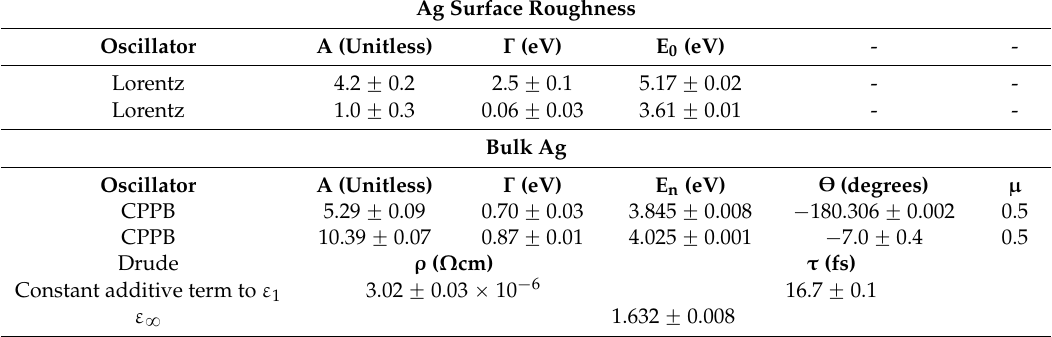
Figure 1. Complex dielectric function spectra, ε = ε 1 + i ε 2 , (arrow pointing left for ε 1 axis, arrow pointing right for ε 2 axis) from 0.734 to 5.88 eV for a semi ‐ infinite Ag film parameterized with a combination of a Drude oscillator and two oscillators assuming critical point parabolic bands (CPPB) with parameters listed in Table 2. Table 2. Parameters describing complex dielectric function ( ε = ε 1 + i ε 2 ) and structure for a semi ‐ infinite Ag film on a borosilicate glass over coated by Cr before ZnO deposition. Experimental ellipsometric spectra were collected in situ after deposition at room temperature in the spectral range from 0.734 to 5.88 eV and fit using least square regression analysis with an unweighted estimator error function, = 5 × 10 − 3 . For bulk Ag, the parameterization of ε consisted of a Drude oscillator, two oscillators assuming critical point parabolic bands (CPPB), and a constant additive term to ε 1 denoted ε . Spectra in ε for the 30 ± 2 Å surface roughness layer were parameterized with two Lorentz oscillators and ε =